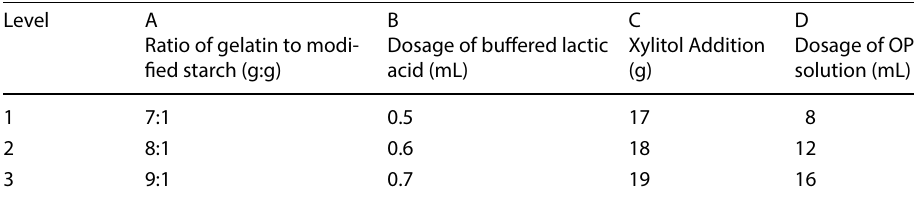
Table 1 Orthogonal test factors and horizontal design